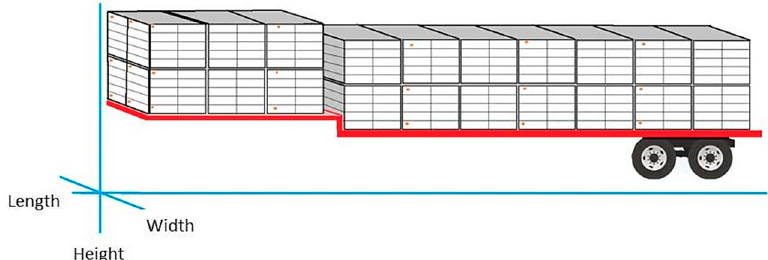
consist of those on driver and curb sides.